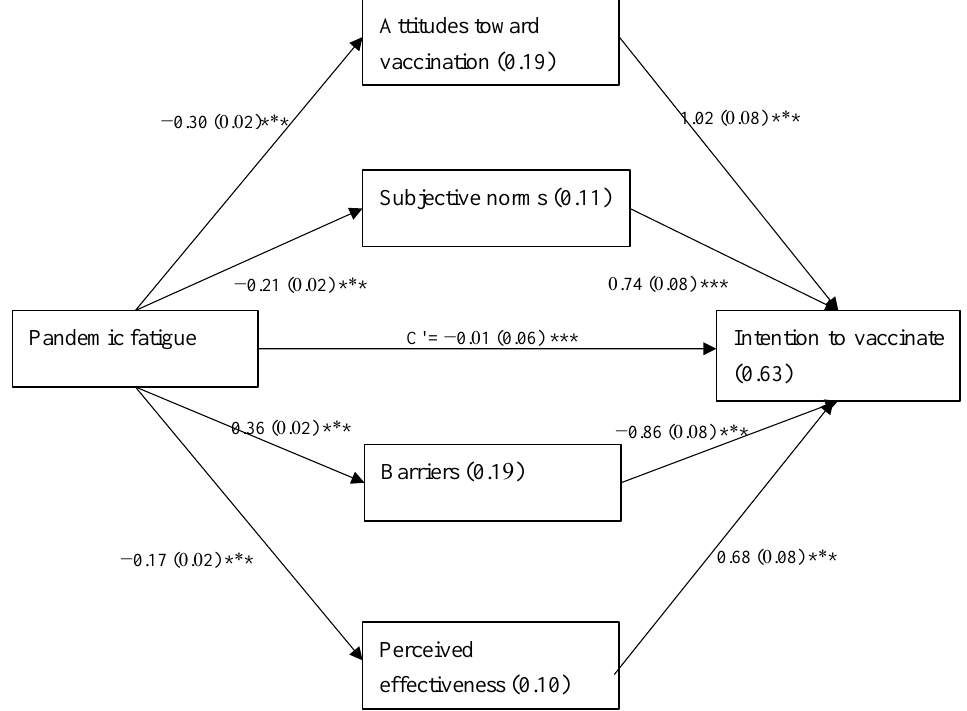
Figure 2. Process model for the indirect effect between pandemic fatigue and the intention to vaccinate the child/ren. Note: Values on arrows: B ( SE ), values within rectangles: R 2 , C’ = direct effect. *** p < 0.001